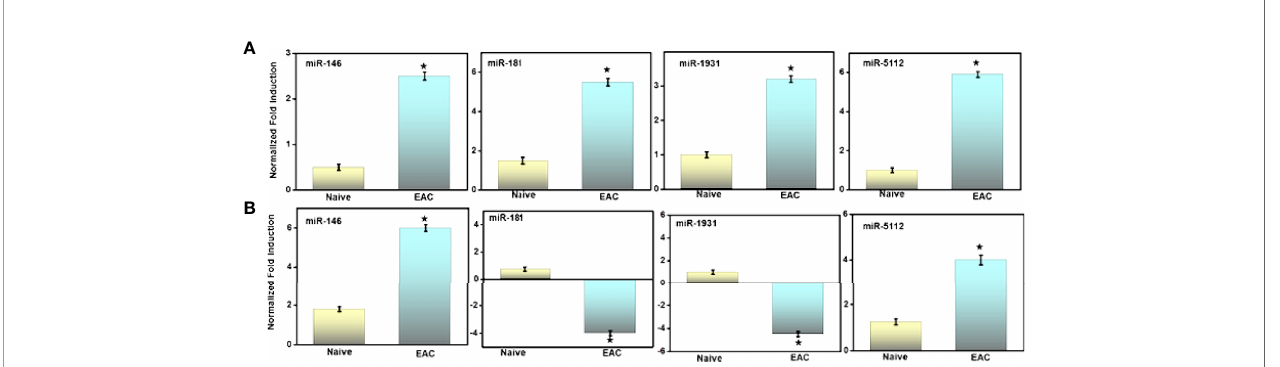
FIGURE 4 | Validation of selected miRs by RT-PCR analysis after IC development. (A) As shown in the fi gure is quantitative RT-PCR verifying upregulation of miRs- 146, -181, -1931, and -5112, in urinary bladder after IC development. (B) Similarly, the relative expression of iliac lymph nodes miRs 146, -5112 are upregulated, while miRs 181, -1931 are downregulated at iliac lymph nodes sites. Data are expressed as mean ± S.E.M. Statistical signi fi cance was calculated using the student ’ s t-test. *P > 0.05 control group alone versus IC